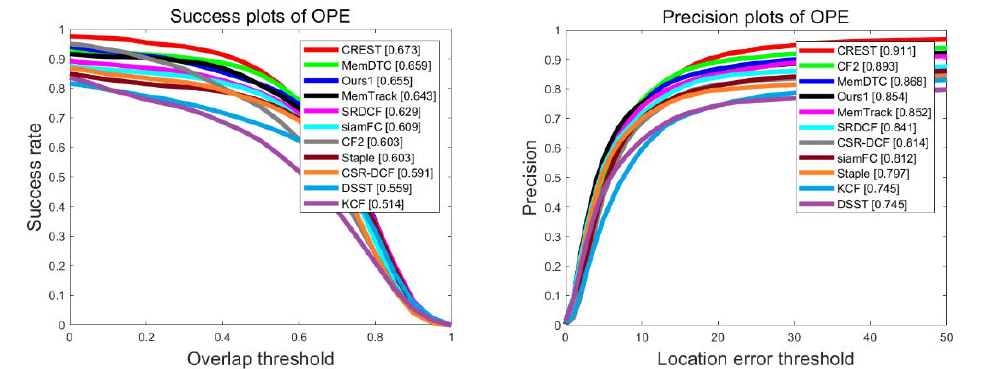
Figure 6. Success and precision rates on the OTB50 dataset.